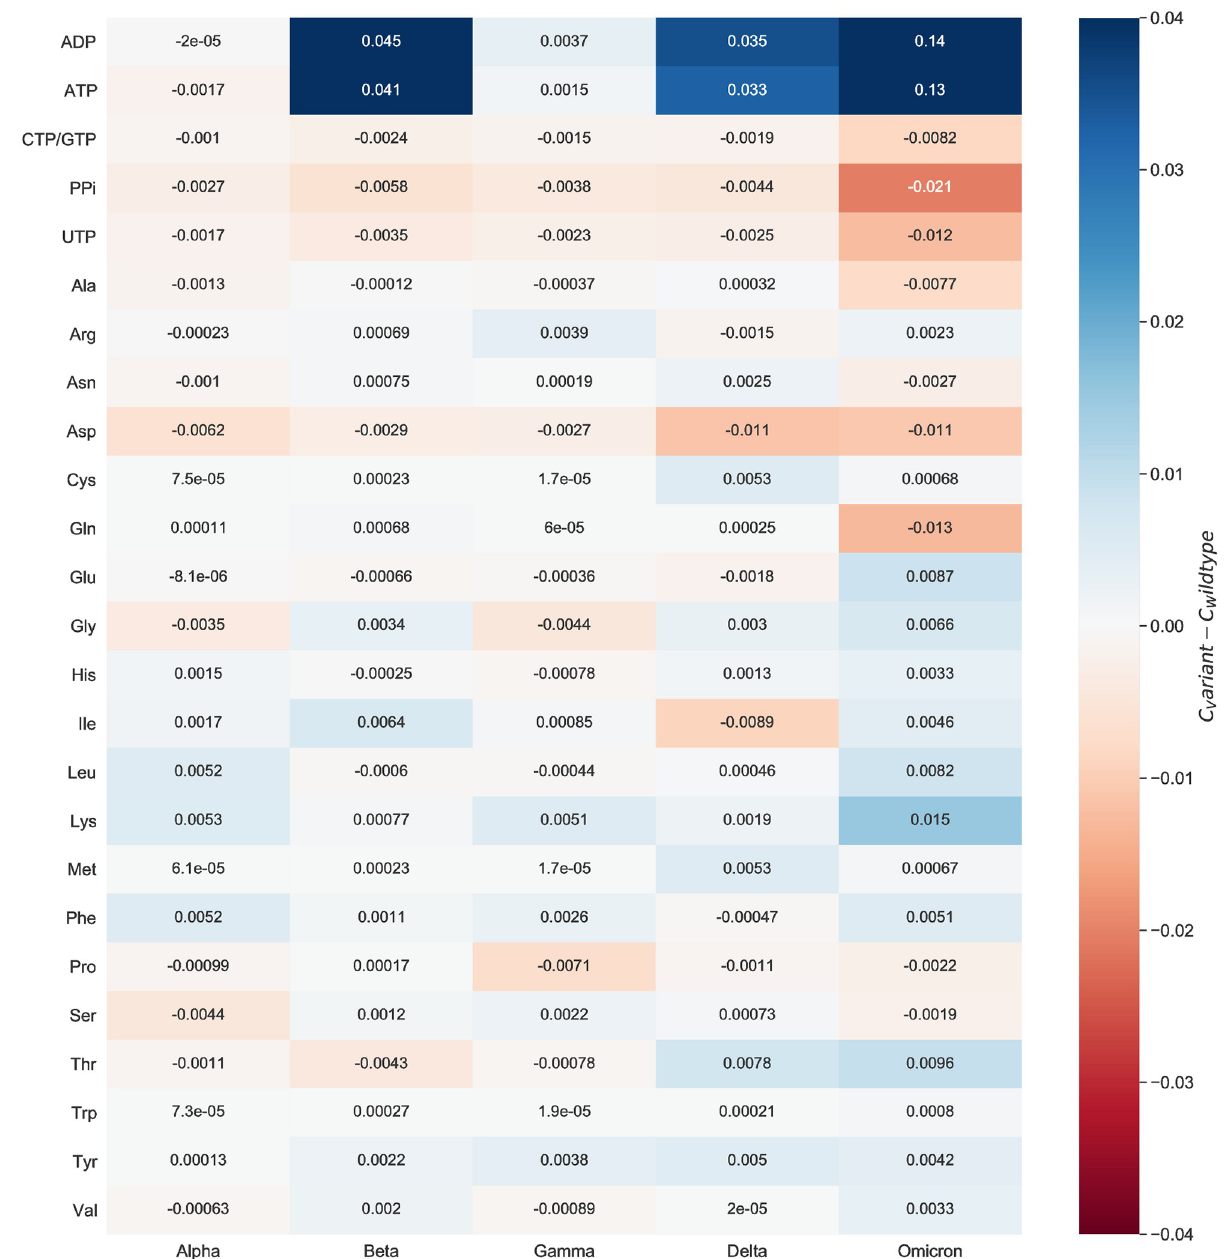
Fig 8. Variant-wise comparison of stoichiometric coefficients derived directly mutated sequences and the wildtype. The difference between the average stoichiometric coefficients of the individual variants and the reference sequence was computed. Red color highlights decreased stoichiometric coefficients in the variants, while increased coefficients are colored by blue. A remarkable increase can be observed in the stoichiometric coefficients of ATP and ADP between the Omicron variant and the wildtype. The stoichiometries of charged and hydrophobic amino acids were higher for the Omicron variant. All in all, the variations between mutants and wildtype are very